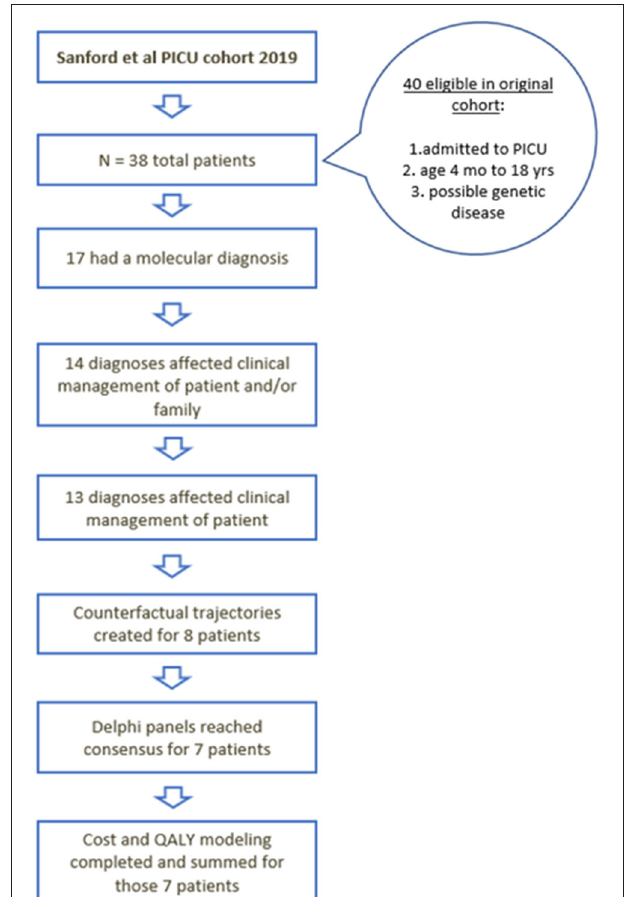
FIGURE 2 | Flow diagram of the children who were initially included, received diagnosis, had changes in management, and underwent cost utility analysis.